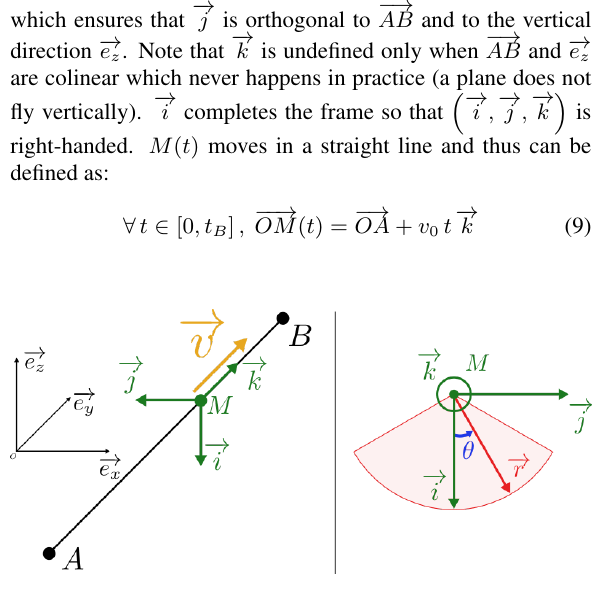
Figure 2. Left: Global frame and flight trajectory. Right: zoom in on the local frame and laser pulse direction. The red-blured area represents the field of view